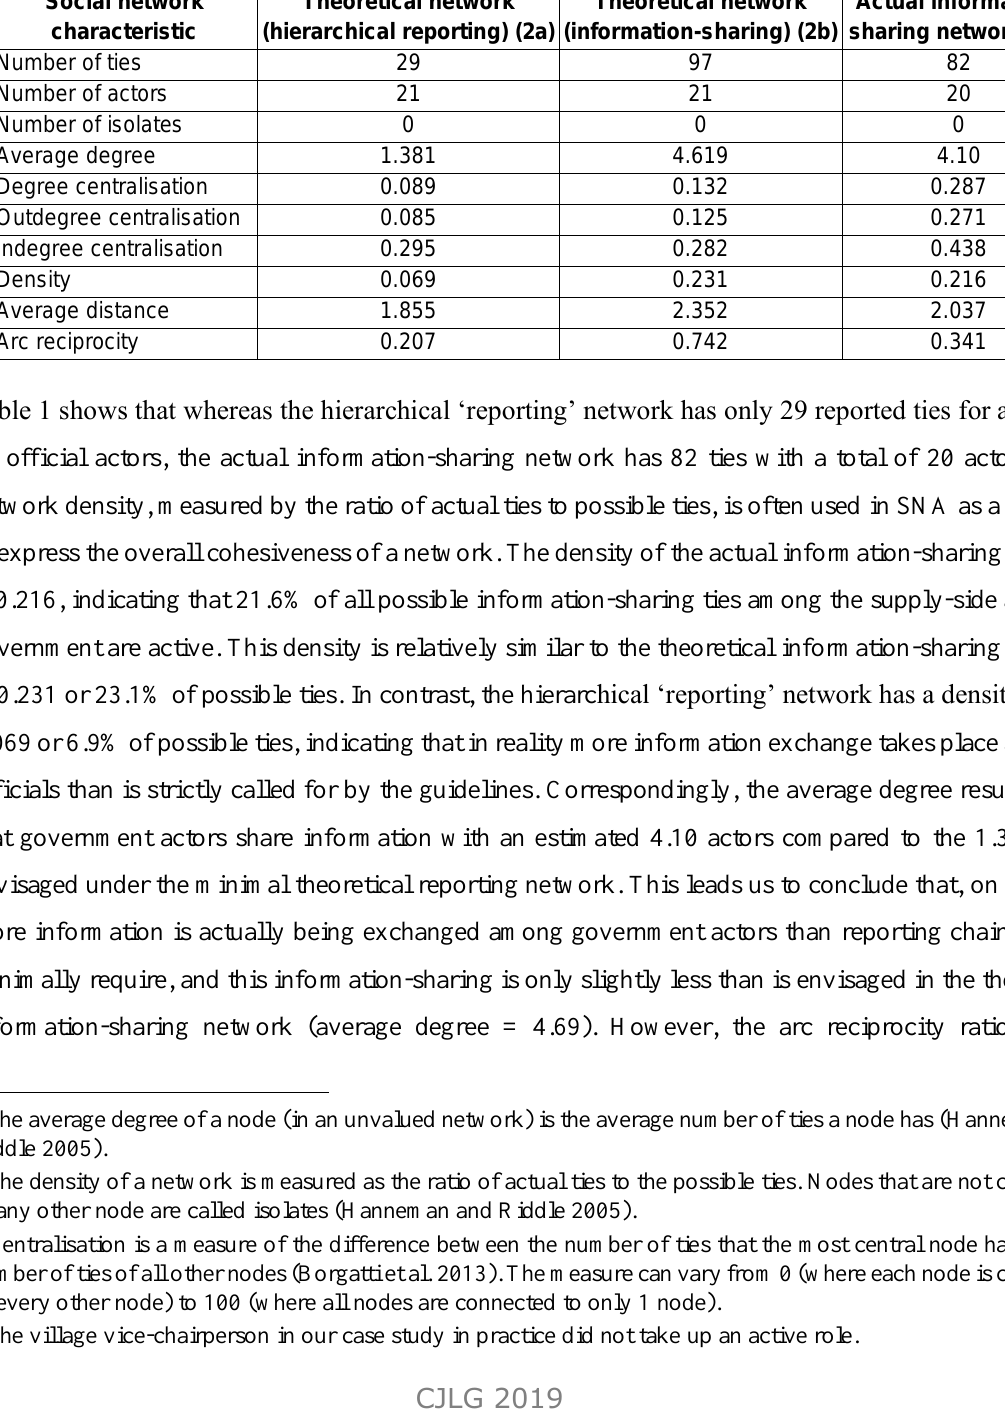
Table 1: Descriptive network characteristics of the theoretical & actual information-sharing networks Social